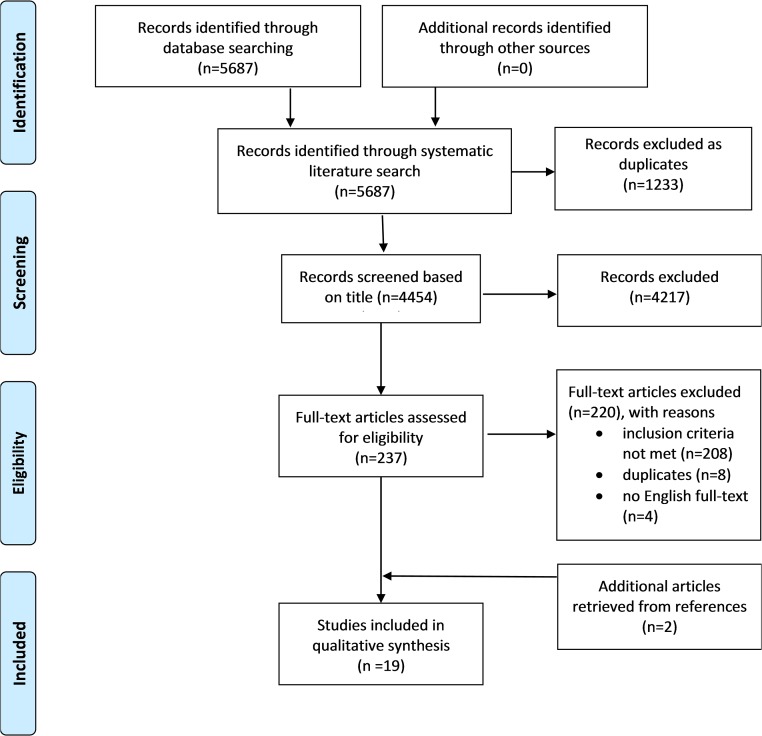
Flow chart of the study selection process.